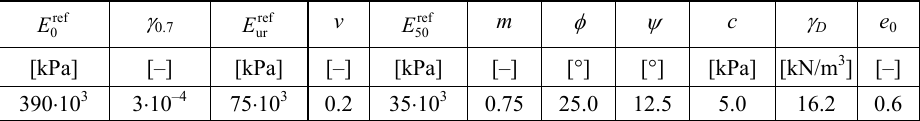
Table 1. Material parameters of London clay for HSs model